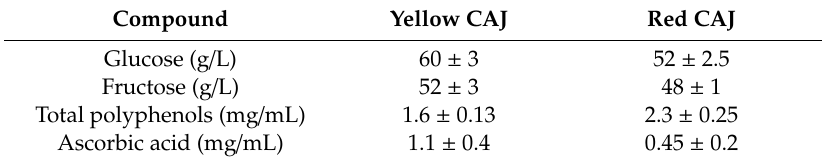
Table 2. Composition of cashew apple juice (CAJ) from yellow and red varieties of cashew